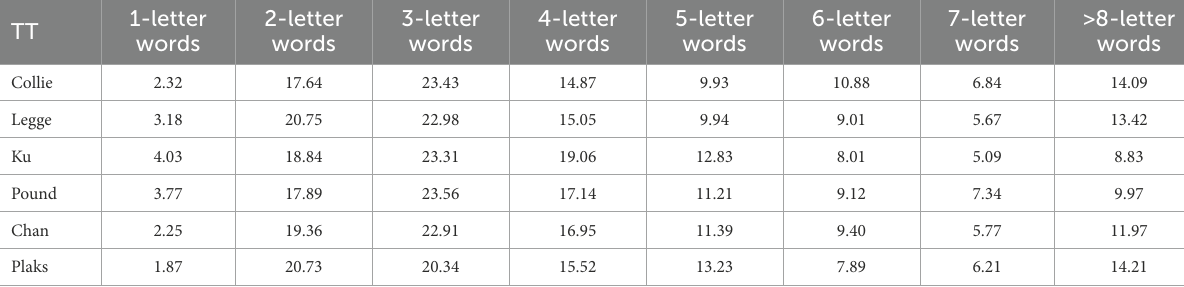
TABLE 4 Word length details of the six TTs (in